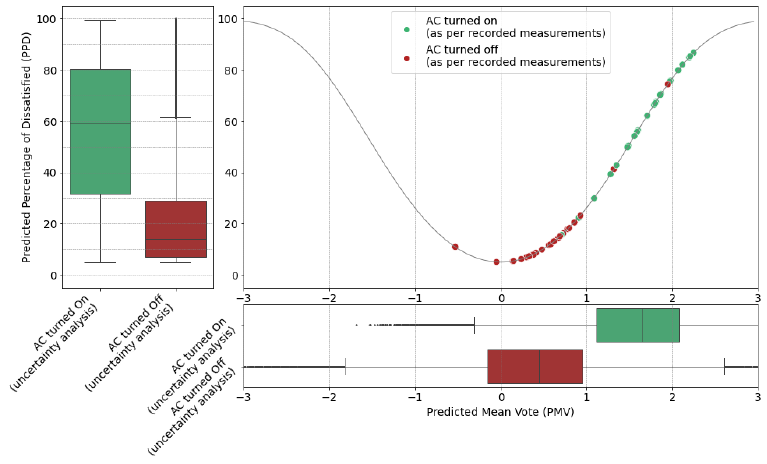
Figure 5. Relation between thermal comfort indices PMV-PPD and AC on and off status. Table 4. Assumed ranges of values for calculating uncertainty in PMV-PPD.